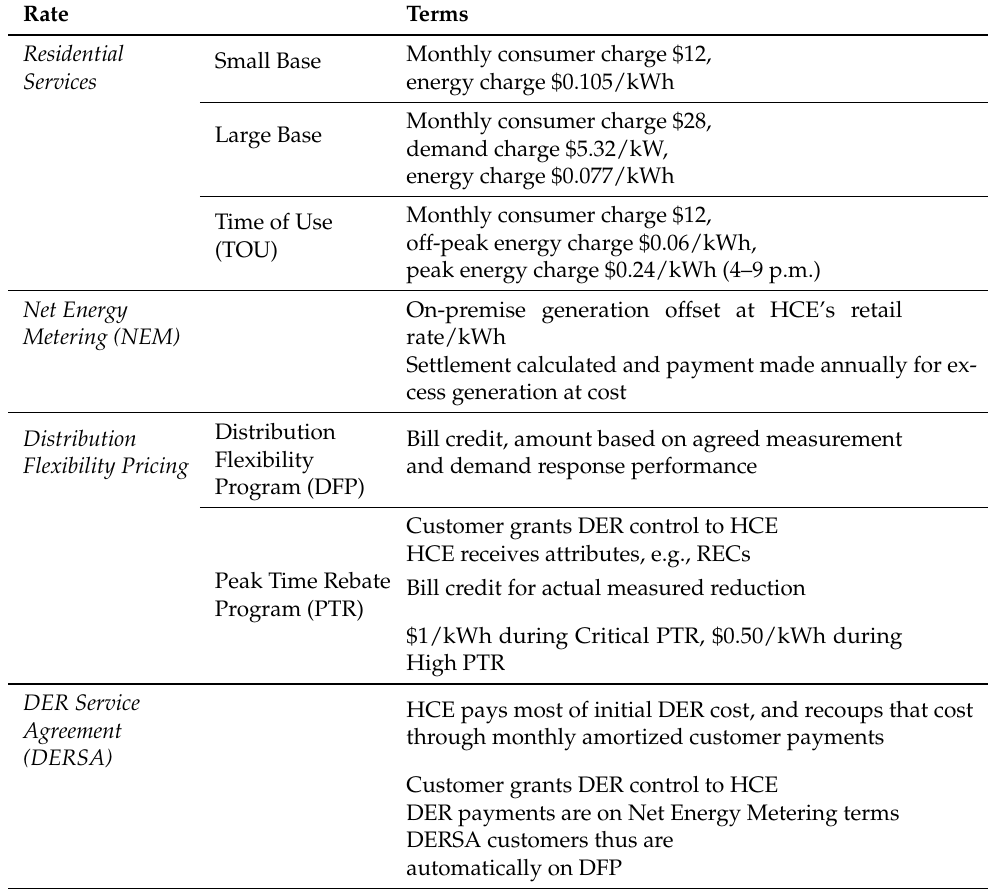
Table 3. Holy Cross Energy Residential Rate